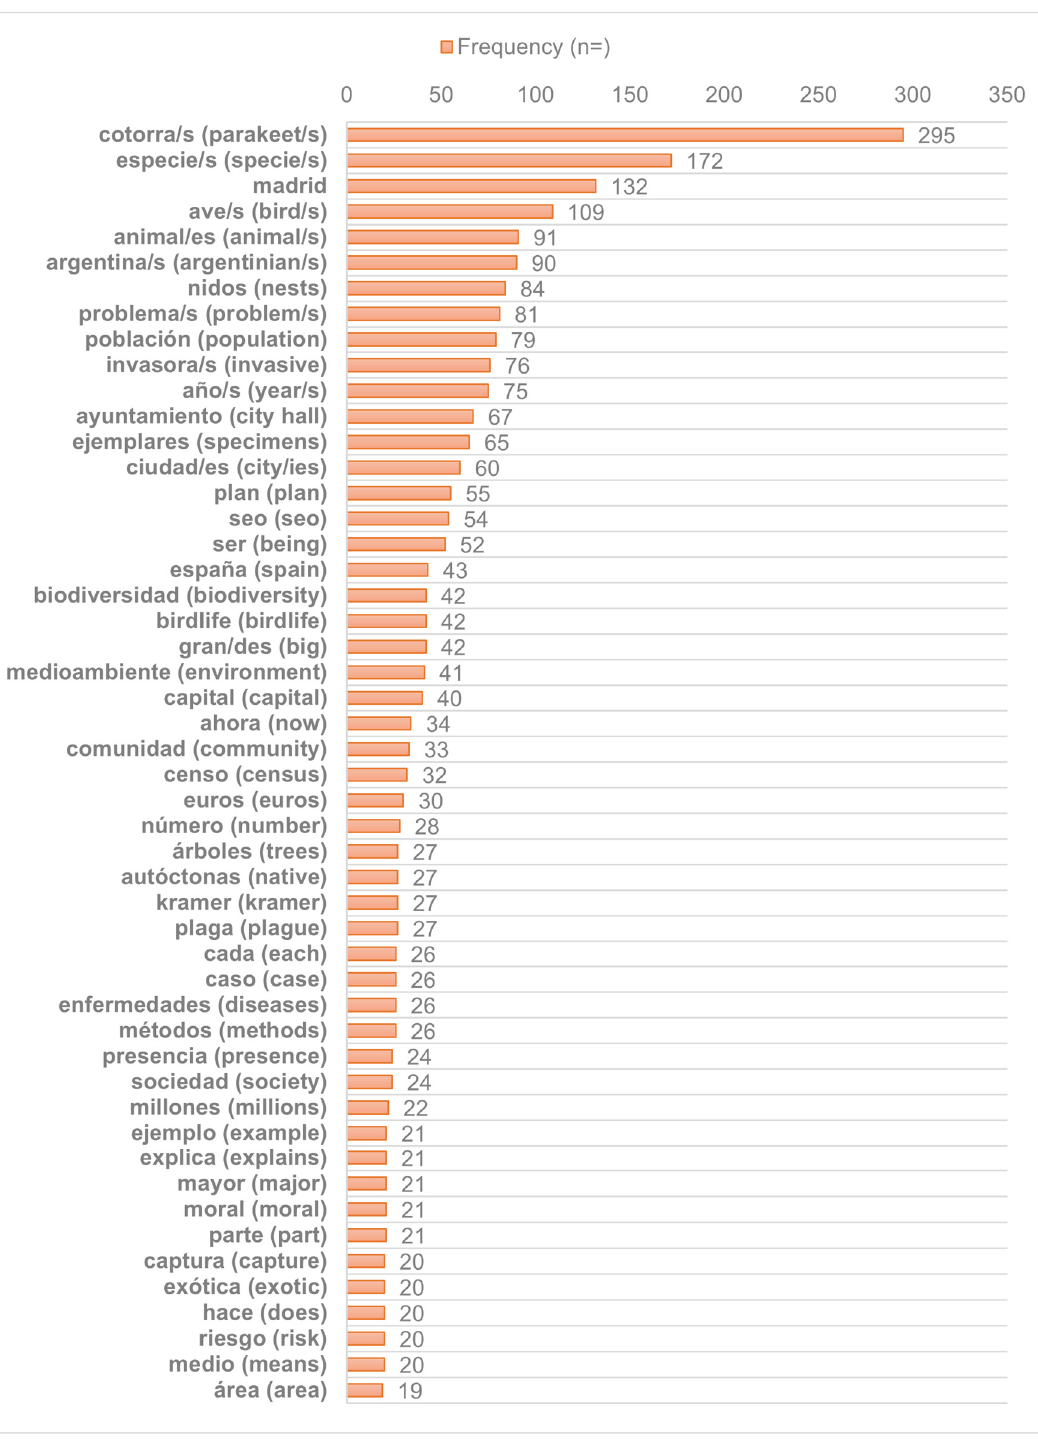
Figure 4. The 50 most frequent words. Source: Own elaboration from texts from El País , El Mundo , ABC , elDiario.es , Público , and El Español .